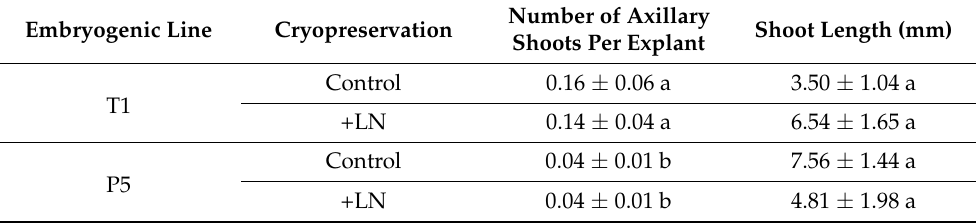
Table 2. Effect of cryopreservation on in vitro multiplication of olive shoots derived from control and cryopreserved embryogenic cultures of the lines T1 and P5. Data represent the mean ± SEM. Different letters indicate significant differences by the LSD test, with a significance level of 0.05.